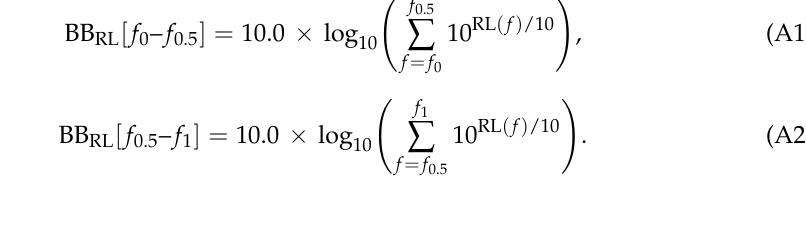
Table A1. 1/3-Octave